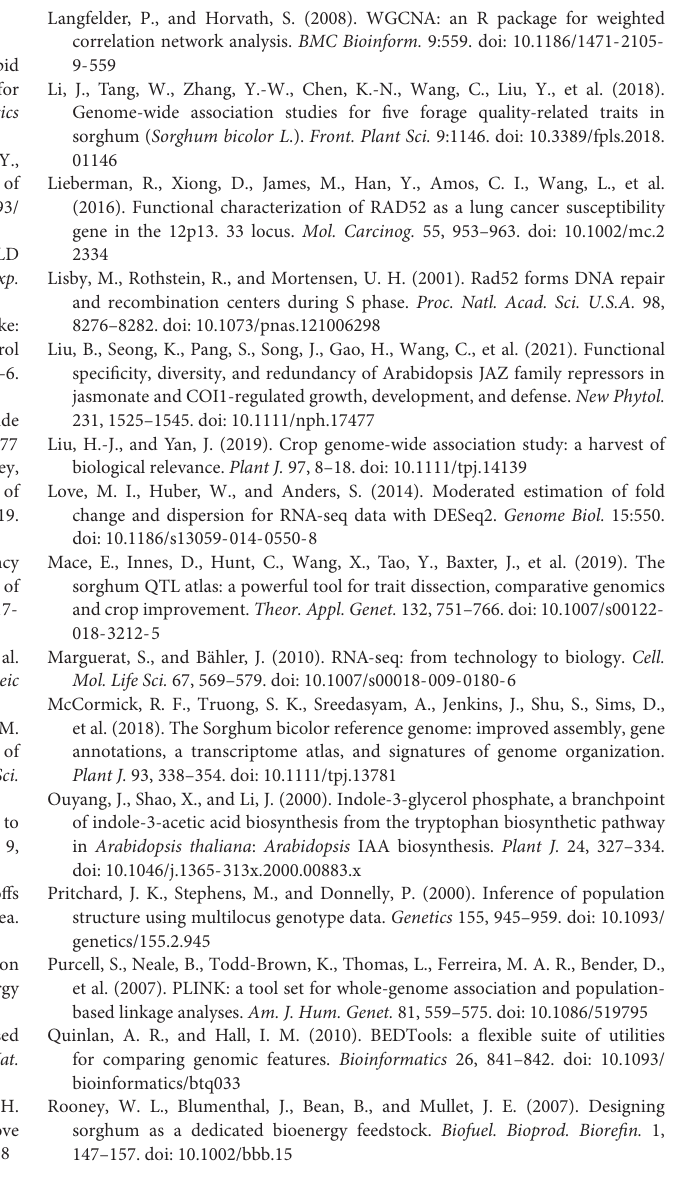
Supplementary Figure 1 | The KEEG enrichment for genes in blue module and turquois module. (A) The KEEG enrichment for genes in blue module. (B) The KEEG enrichment for genes in turquois